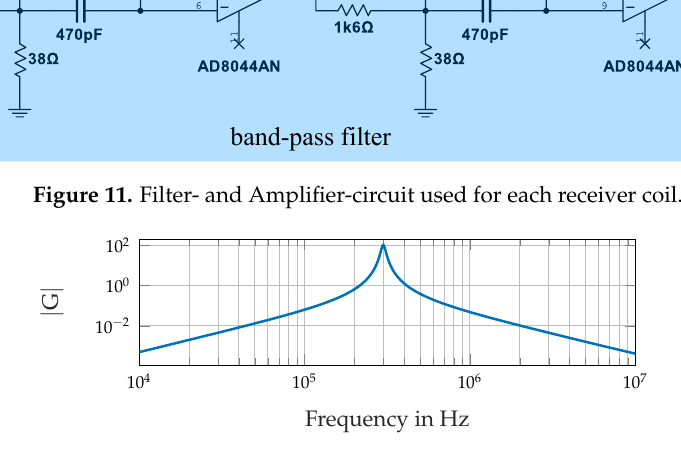
Figure 12. Frequency response of the filter circuit shown in Figure